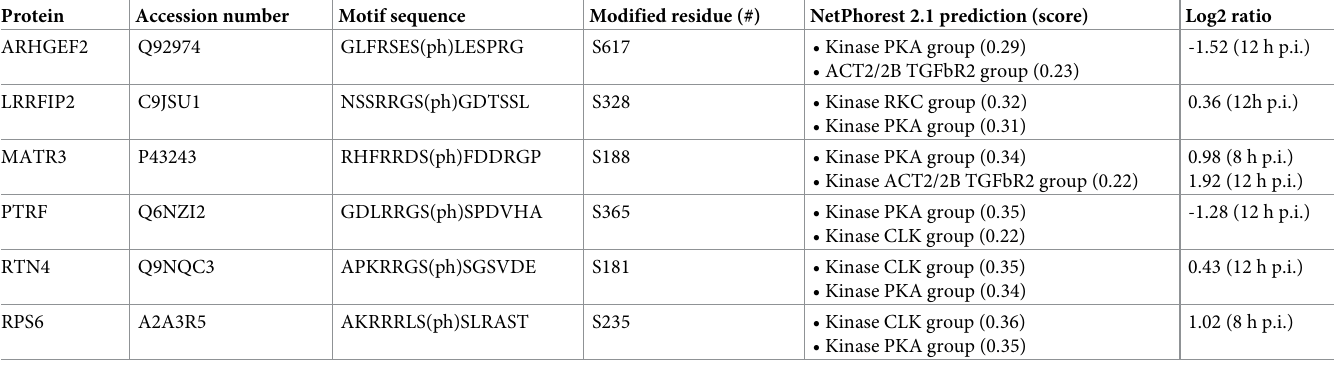
(ph) indicates the preceding amino acid residue was modified by phosphorylation. # amino acid residue number according to PhosphoSitePlus